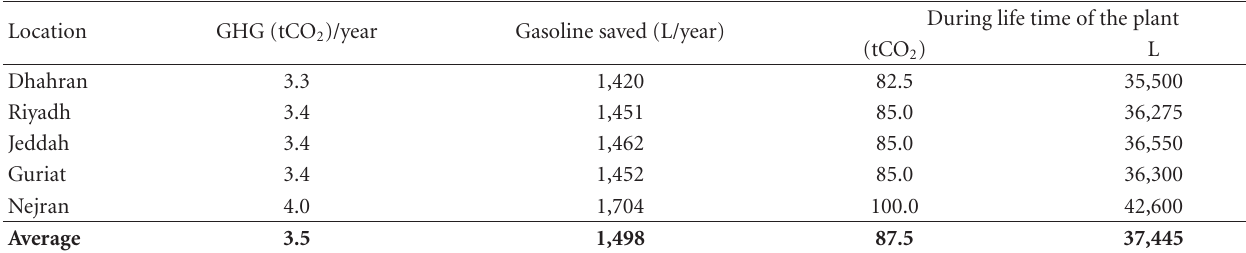
Table 5: Summary of greenhouse gases avoided as a result of PV power utilization for water pumping in Saudi Arabia at di ff erent